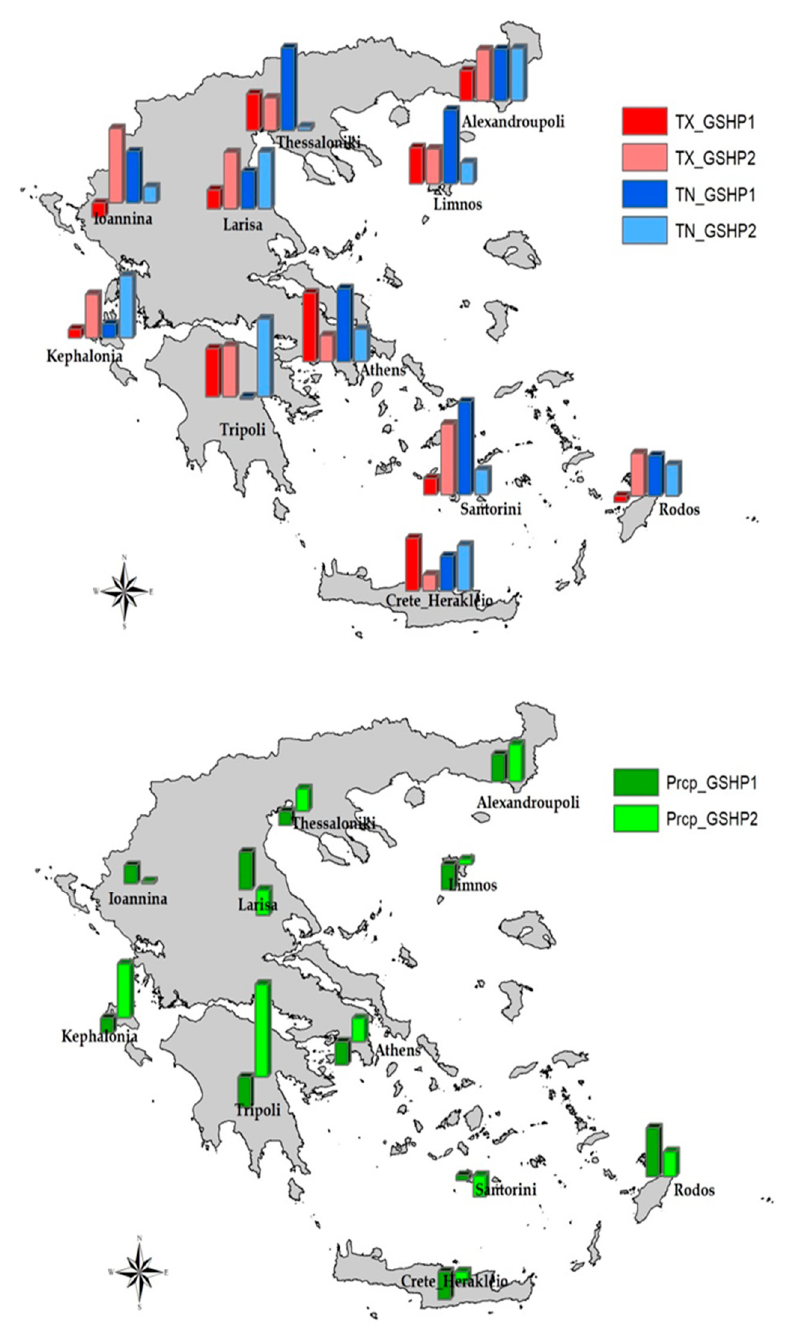
Figure 2. Magnitudes of trends of mean maximum (TX, red bars) and minimum (TN, blue bars) air temperature (°C) and precipitation (PRCP, mm, green bars) during the period of records (HP1: 1980– 1999 and HP2: 2000–2019) over the growing season